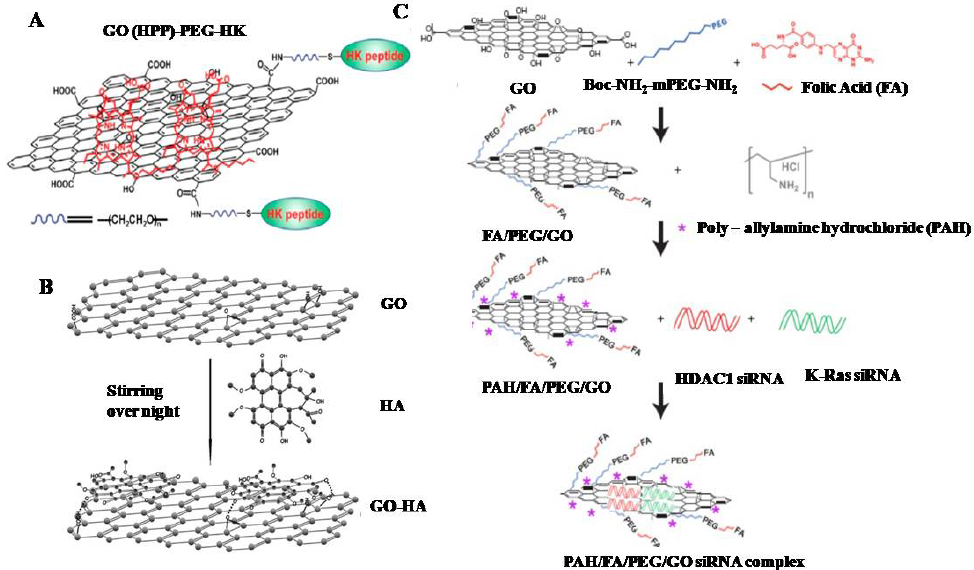
Figure 1. Schematic. ( A ) Structure of GO(HPPH)-PEG-HK [42]. ( B ) Diagram of the synthesis and functionalization to prepare GO-HA hybrid [43]. ( C ) The synthesis and functionalization to prepare PAH/FA/PEG/GO siRNA complex [44]. Reprinted/adapted with permission from Refs. [43,44]. Copy right 2011, copyright Wiley-VCH. Copy right 2017, copyright Ivyspring.